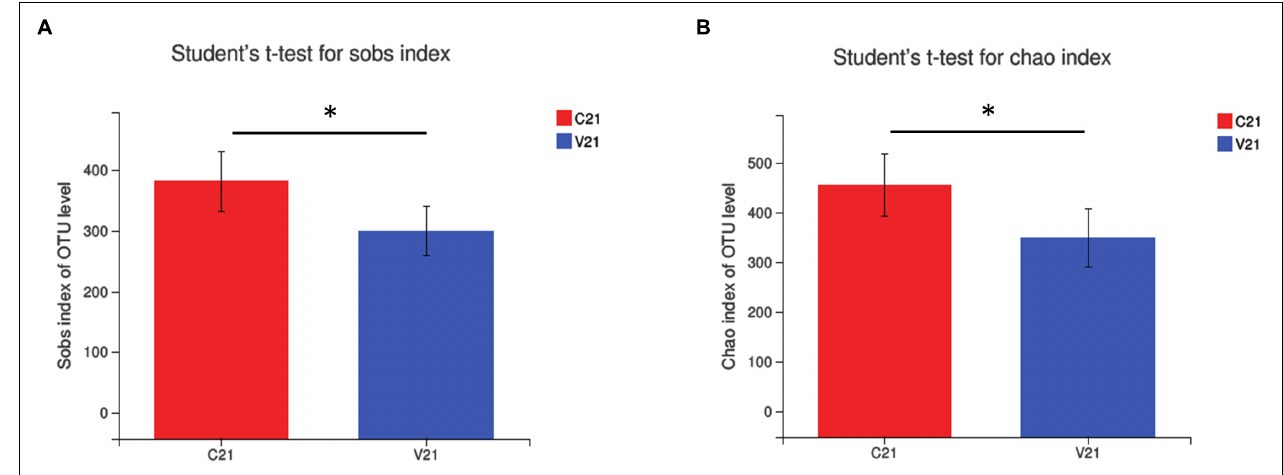
FIGURE 2 | Changes in alpha diversity of gut microbiota in PCV3- (V) and sham-inoculated (C) piglets were analyzed using (A) Sobs index and (B) Chao index. Statistical differences at 21 days after PCV3 inoculation were calculated. Values are expressed as mean ± SD, with four piglets per group. ∗ P < 0.05.